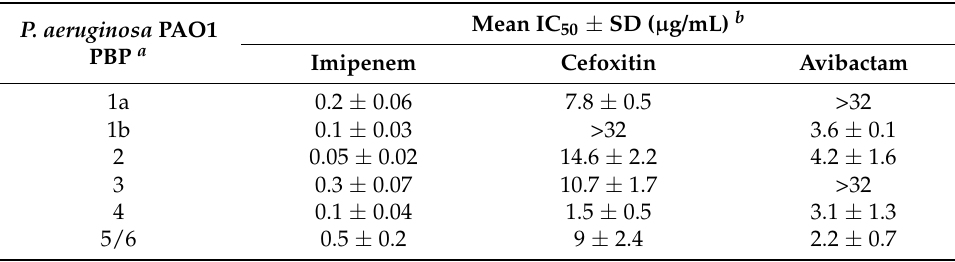
Table 1. PBP-binding affinities (IC 50 ) of imipenem, cefoxitin and avibactam for P. aeruginosa PAO1 isolated PBP-containing membranes.